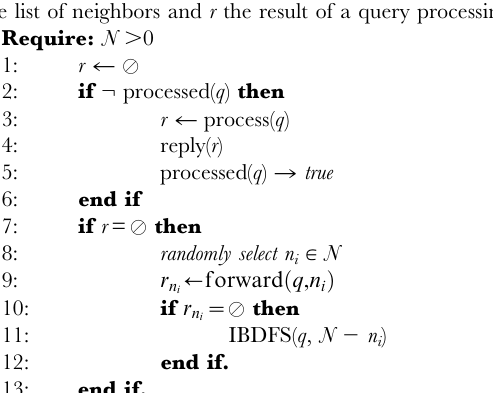
Algorithm 1 IBDFS(q, N): let q be the query to be processed, N the list of neighbors and r the result of a query processing